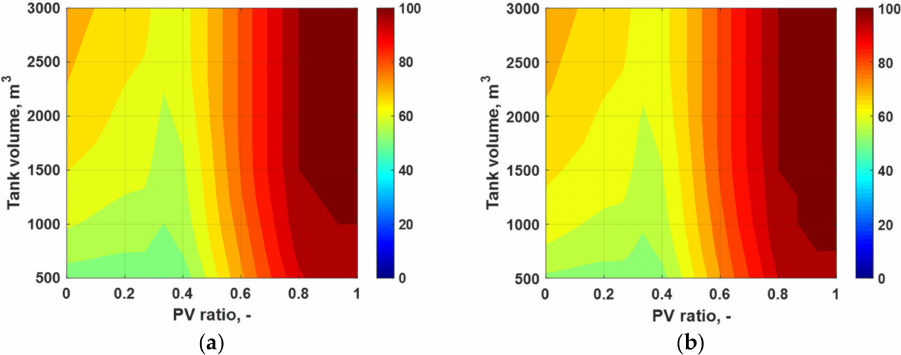
Figure 15. Variation of the SCR (%) for Svishtov (wine grapes), with a 15 kW HRES, with mSi PV technology and WT type 3 ( a ) without battery; ( b ) with